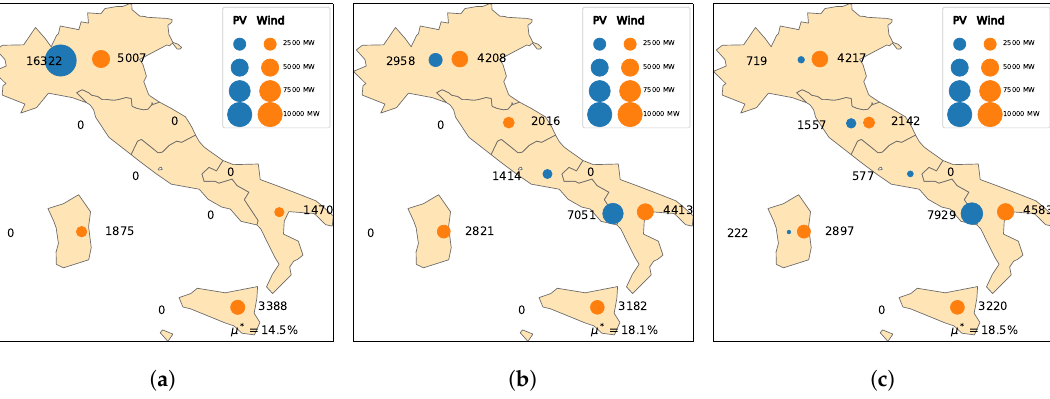
Figure 5. PV-wind capacity distributions obtained from the CORDEX hourly data for the global strategy with the total-capacity constraint. The left, middle and right panels represent the optimal mixes for the minimum-variance ( a ), maximum mean-standard deviation-ratio ( b ) and high-penetration mixes ( c ), respectively (blue dot, black dot and blue diamond in Figure